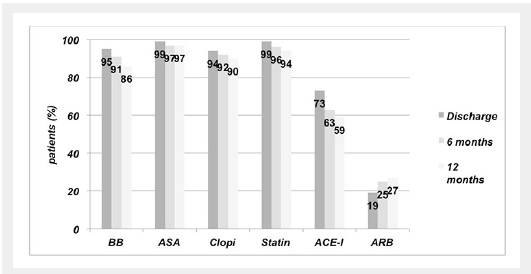
Secondary prevention medication after myocardial infarction (n = 204) at hospital discharge, and 6 and 12 months after discharge. ACE-I = angiotensin-converting enzyme inhibitor; ARB = angiotensin receptor blocker; ASA = acetylsalicylic acid; BB = beta- blocker; clopi =